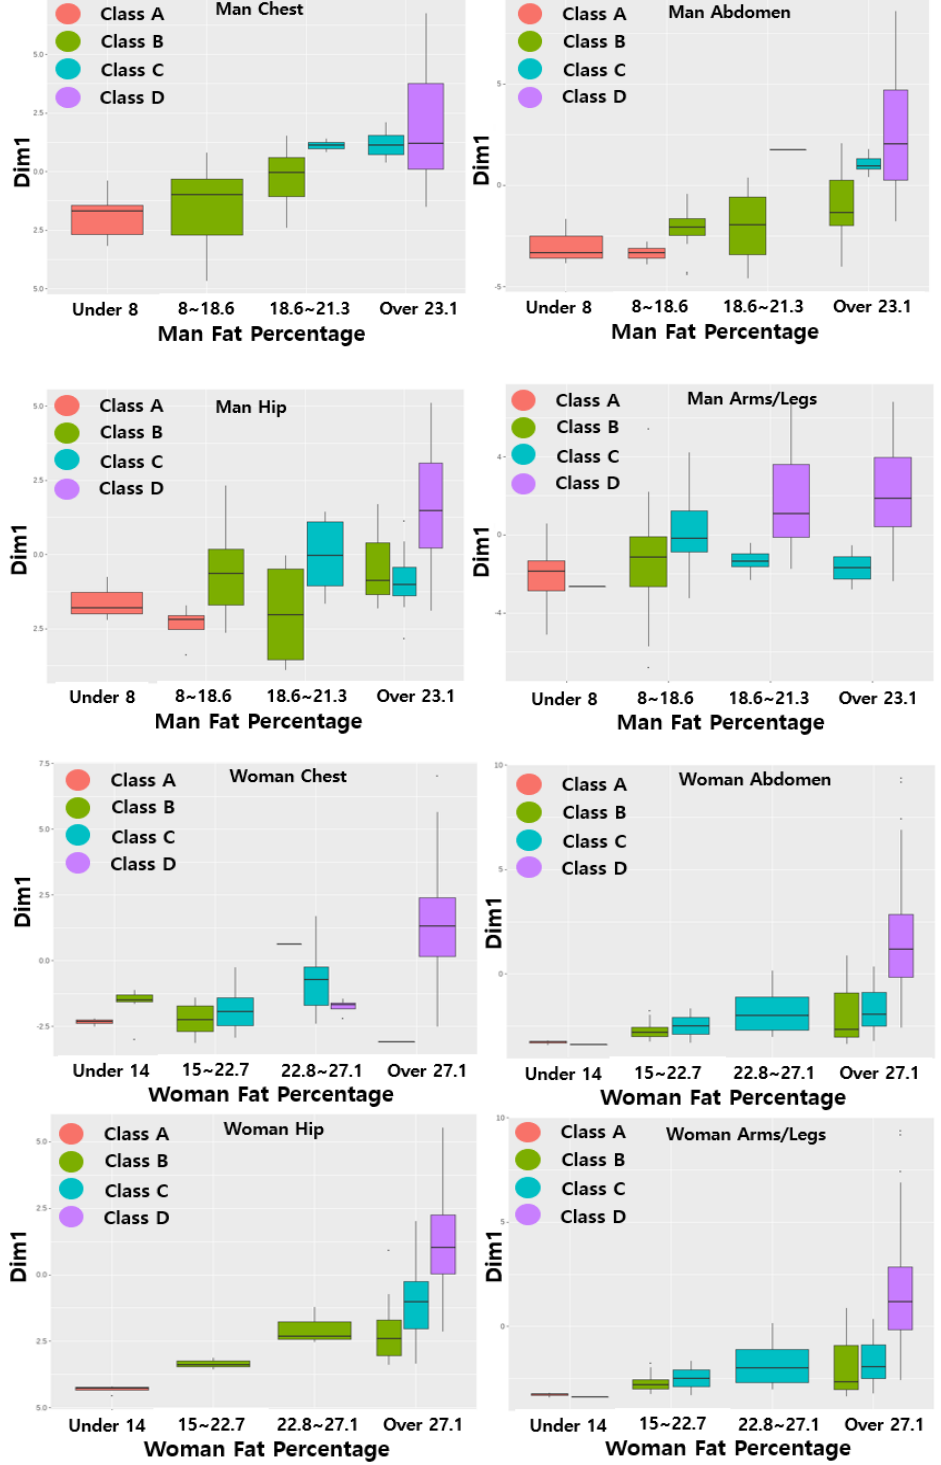
Figure 7. PCA value boxplots of classes A, B, C, and D (males-females). Table 8. Exceptions by group for males and females.